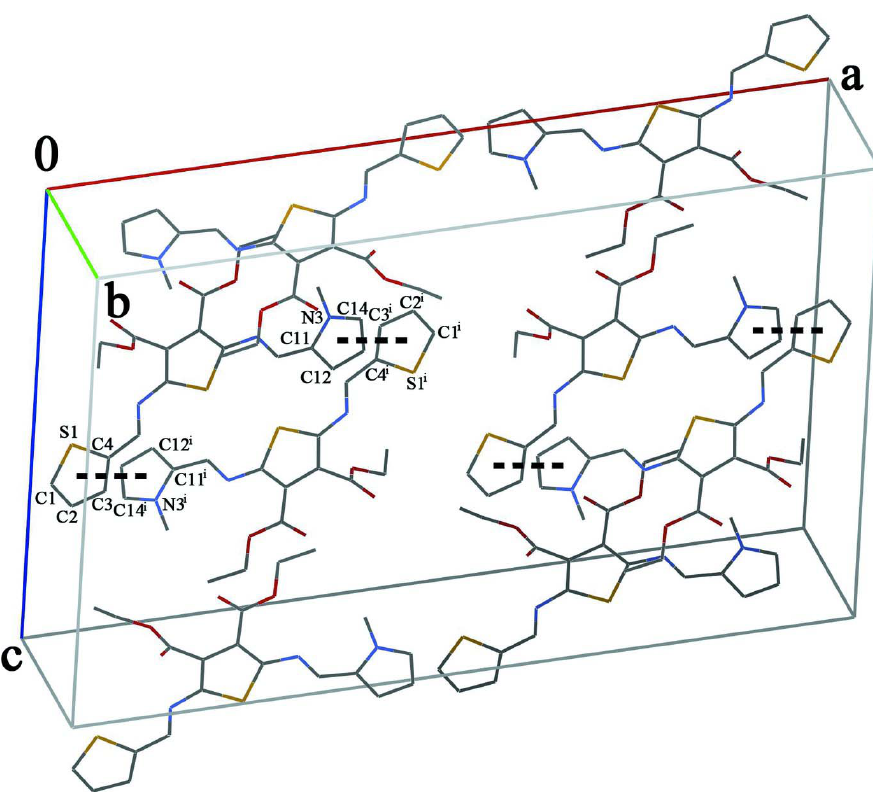
Supramolecular structure showing the intermolecular π -stacking giving the structural arrangement. Dashed lines indicate the π -stacking. The H atoms and disorder was omitted for clarity. [Symmetry codes: (none) x , 1 - y , -1/2 + z ; (i) 1/2 - x , -1/2 + y , 1.5 - z